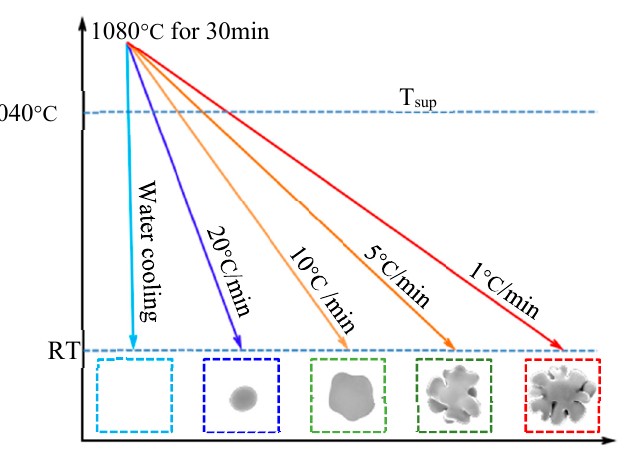
Figure 3. Schematic illustration of the effects of the cooling rates on the morphology of the γ (cid:48) phase. In order to investigate the size and distribution of the primary γ (cid:48) precipitates under different cooling rates, Figure 4 shows the particle size frequency distribution of the equivalent diameter of the γ (cid:48) precipitates. It can be obtained from Figure 4 that an obvious increase in the equivalent diameter with the decreasing of the cooling rates is shown.